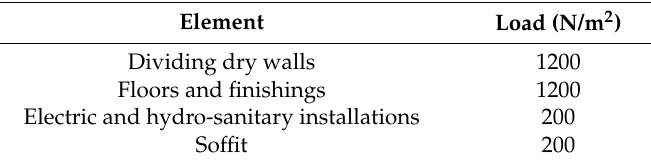
Table 2. Finishings and installations loads.